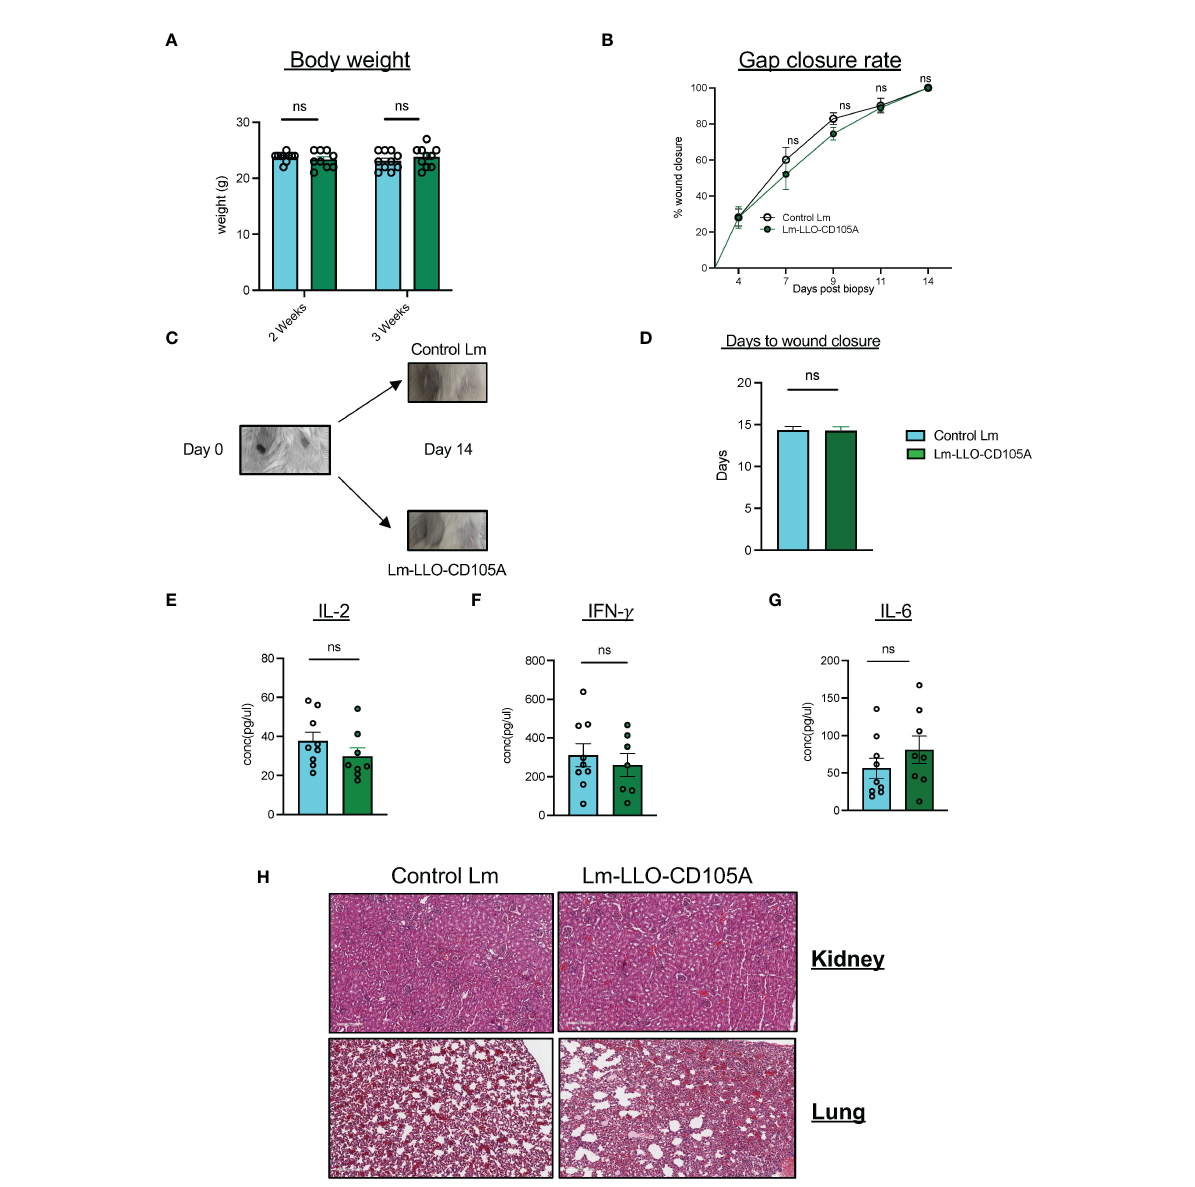
FIGURE 8 Lm-LLO-CD105 has a high safety pro fi le with no effect on wound healing. (A) Body weight of experimental mice post-vaccination. (B) Rate of wound closure after skin biopsy punch between either vaccination groups. (C) Representative image of biopsy punches before and after wound closure. (D) Days to wound closure after biopsy punch. (E, F) Serum concentration of proin fl ammatory cytokines including, (E) IL-2. (F) IFN- g , and (G) IL-6 between Control Lm and Lm-LLO-CD105A groups. (H) Representative images of the immune in fi ltrates to the healthy kidney and lung tissues between the Control Lm and Lm-LLO-CD105A vaccinated groups. n=9-10/group. Data were analyzed using unpaired t-test. *P < 0.05, ns, not signi fi cant. All error bars are shown as mean ±